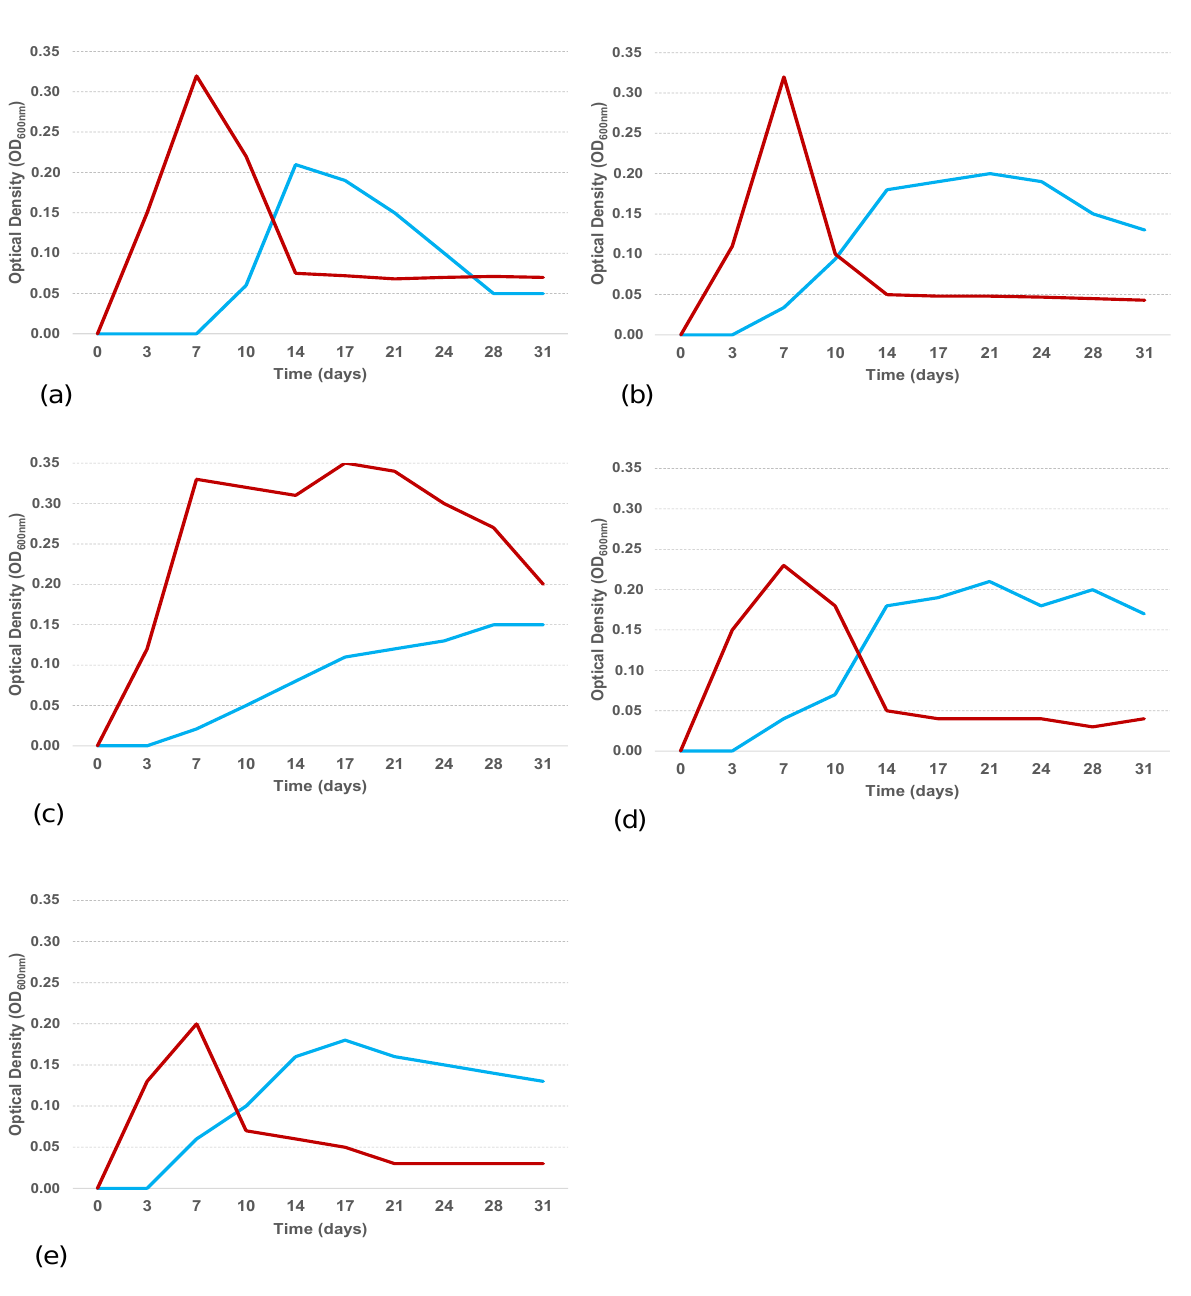
Figure 5. Growth curves at 4 °C (light blue line) and 25 °C (red line) for a/ANT5a ( a ), b/ANT6 ( b ), b/ANT8 ( c ), b/ANT10 ( d ), b/ANT11 ( e ) Alcanivorax strains in ONR7a medium amended with hydrocarbon mixture (PierE1, Dansk Crude Oil, 1 % w / v ).